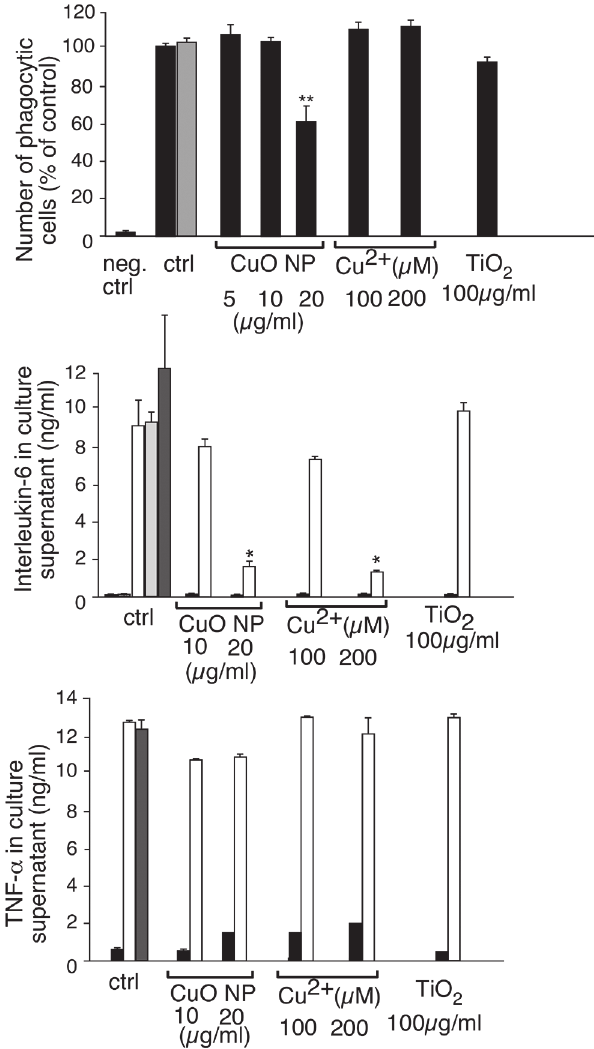
Fig 4. Phagocytic activity and cytokine production of J774 cells upon treatment with particles or copper ion. The phagocytic activity index of the cells is indicated. The results are expressed in percentage of the activity of control cells at 37°C. Negative control: proportion of fluorescent cells when the experiment is carried out without fluorescent beads. Measurements were carried out in triplicate. Statistical confidence (Student T-test) is indicated as follows: * : p (cid:1) 0.05; ** p (cid:1) 0.01; *** p (cid:1) 0.001. Grey bar: phagocytic index of cells treated with PVP only (4 μ g/ml). In panels B and C, the production of respectively IL6 and TNF alpha was assessed. Cells were pretreated for 8 hours with copper ion or with the indicated particles at the indicated concentrations. LPS was then added or not (1 μ g/ml) and the cells left for an additional 18 hours prior to supernatant harvesting and cytokine measurement. Black bars: cytokine production without LPS stimulation. White bars: cytokine production with LPS stimulation. Grey bars: cytokine production with LPS stimulation and treatment with PVP only (2 μ g/ml light grey, 4 μ g/ml dark grey). Hatched bar: cytokine production upon treatment with PVP only (4 μ g/ml) and without LPS stimulation.